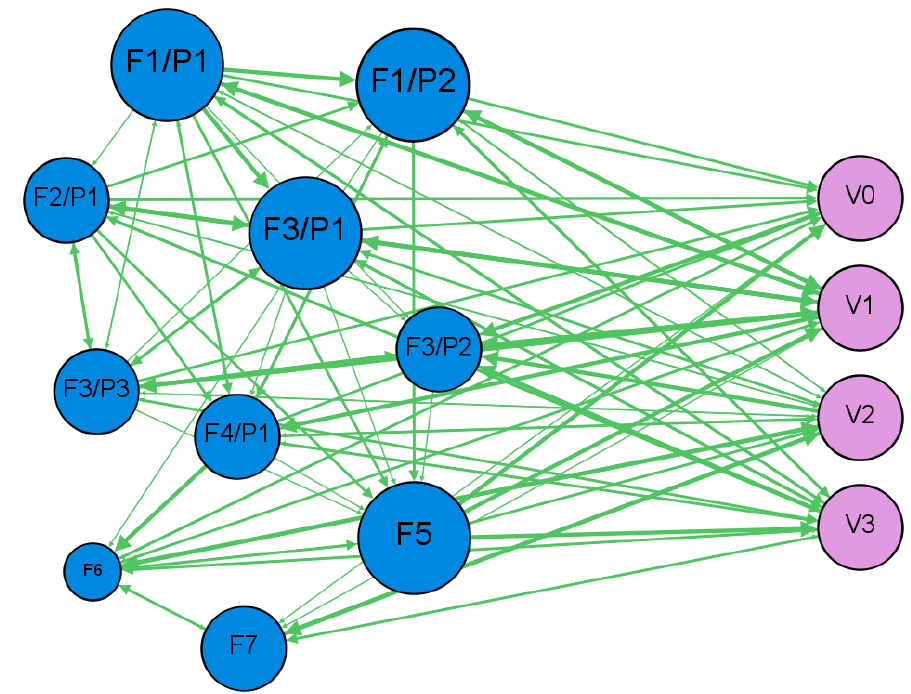
Figure 11. Positive relations that occur between the analysed criteria and decision alternatives according to the first expert's assessment.